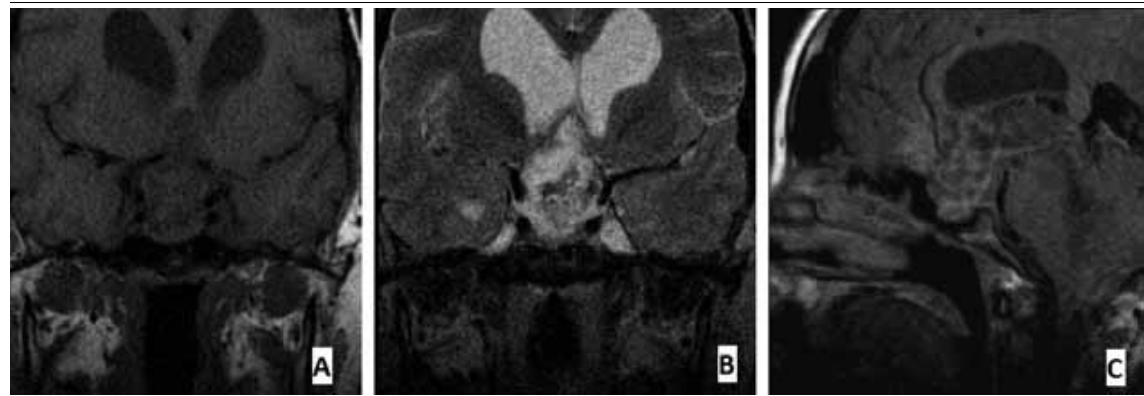
figurE 1 – Pilocytic astrocytoma: an expansive process compromising sellar and suprasellar regions, which compressed the third ventricle and determined hydrocephalus A: coronal T1-weighted image; B: coronal T2-weighted image; C: sagittal postcontrast T1-weighted image.